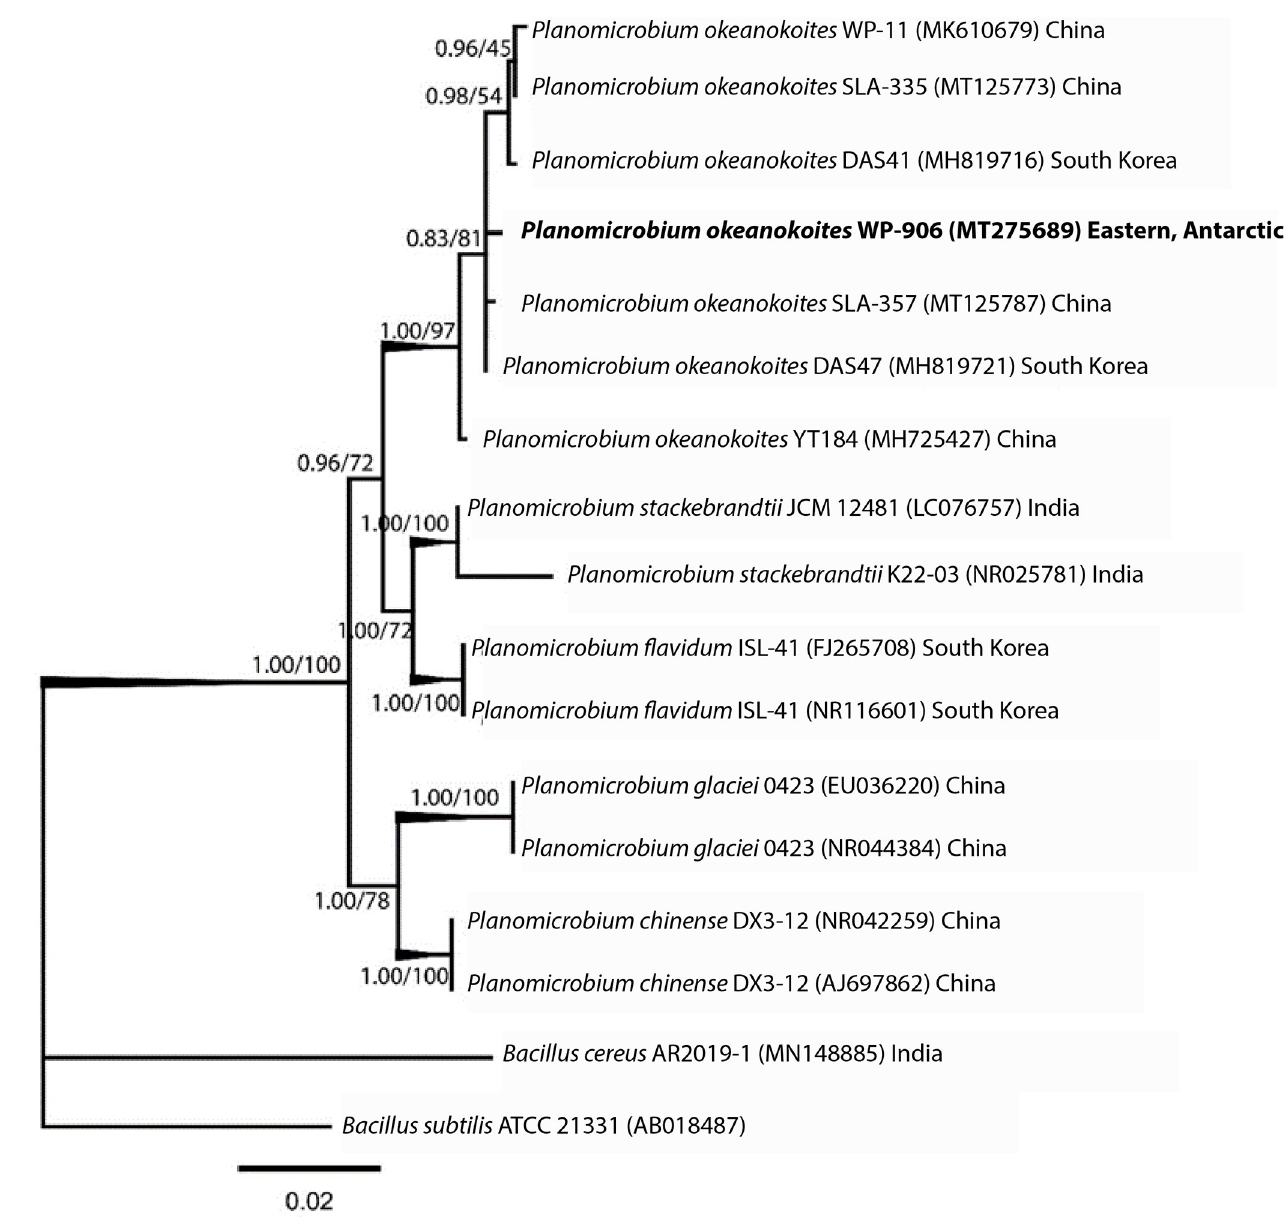
Fig 3. Phylogenetic tree based on the 16S rRNA gene of bacterial isolates constructed by Bayesian inference and maximum likelihood methods (The sequenced P . okeanokoites gene is marked in bold).